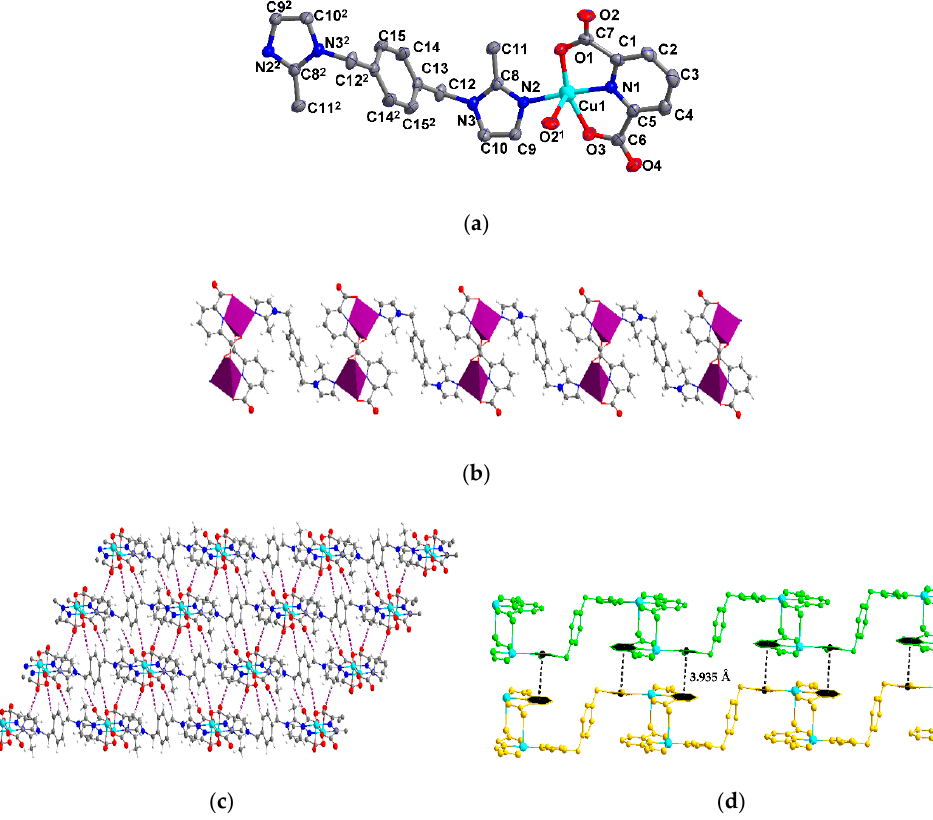
Figure 2. The structure of compound 2 : ( a ) coordination environment of the Cu(II) ion (symmetry transformations used to generate equivalent atom codes: 1 − X, 1 − Y, 2 − Z; 2 − X, 1 − Y, 1 − Z); ( b ) polyhedral representation of the 1D Z-type chain structure; ( c ) 2D layer formed by hydrogen bonding; ( d ) 3D supramolecular structure formed by π ··· π interactions (green, Cu; red, O; blue, N; black, C).